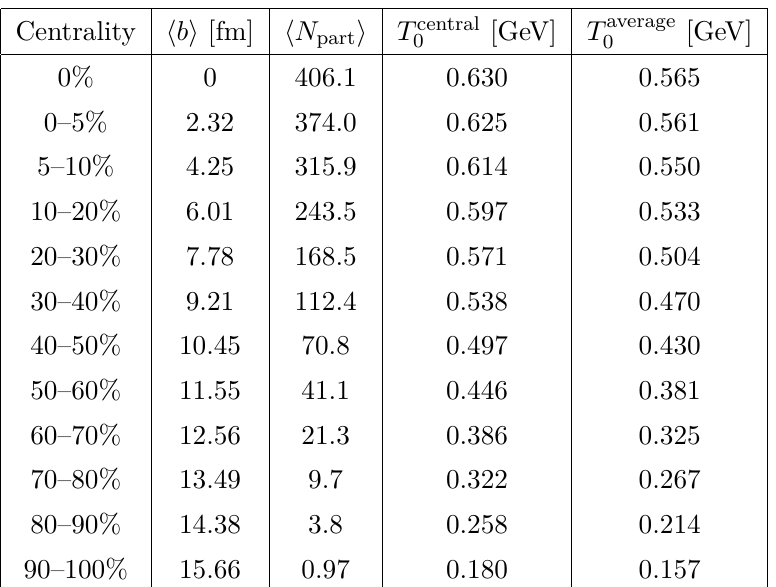
Table 1 . The average impact parameter, number of participants, initial central temperature, and path-averaged temperatures in centrality classes appropriate for a